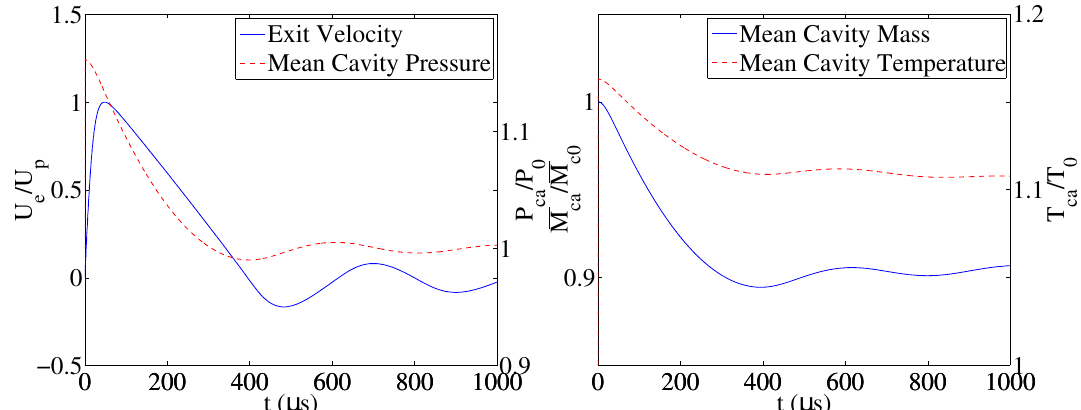
Figure 11. Temporal evolution of ( left ) jet exit velocity and mean cavity pressure; ( right ) mean cavity temperature and mass, during the start-up first